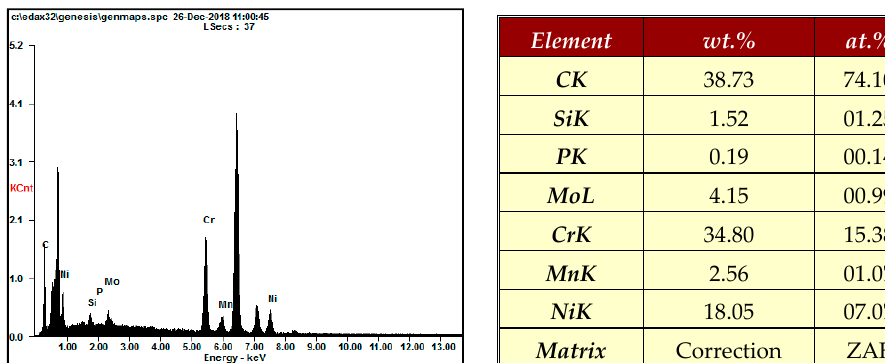
Figure 12. Chemical elements of 316L SUS wire before finishing.